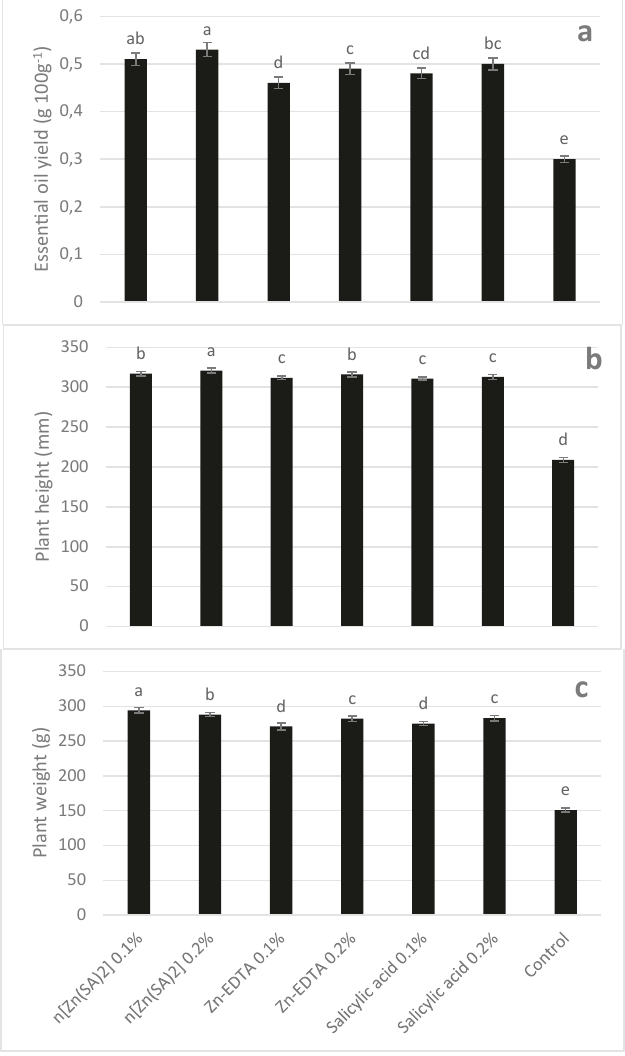
Fig. 2: Essential oil yield (a), plant height (b) and plant weight (c) of sweet basil under different zinc and salicylic acid sources. Values are means ± SE (n = 8). Bars having different letters are significantly different at the 5% level by Duncan’s multiple range